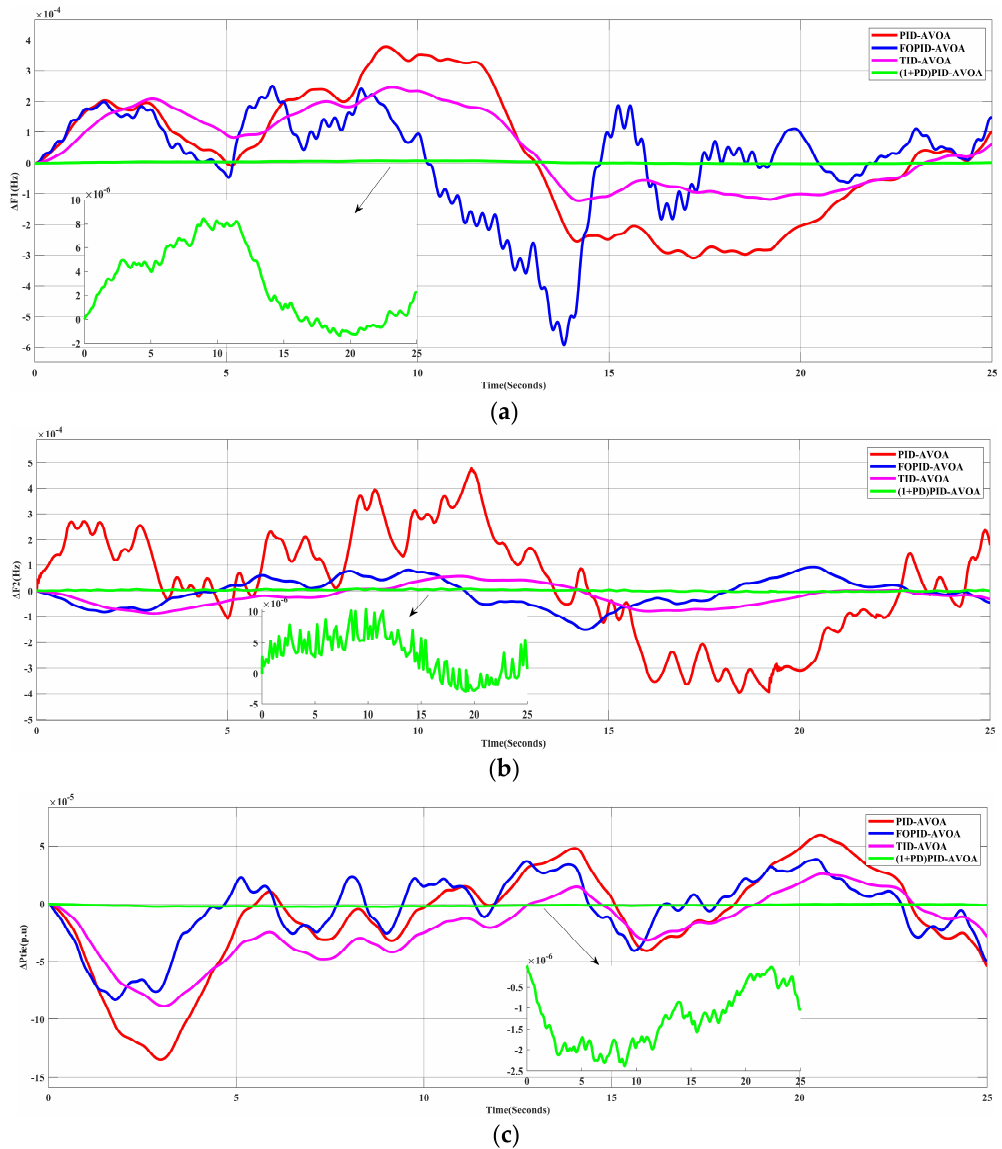
Figure 12. System responses under RES insertion for: ( a ) Δ F 1 , ( b ) Δ F 2 and ( c ) Δ 𝑃 (cid:3047)(cid:3036)(cid:3032) .